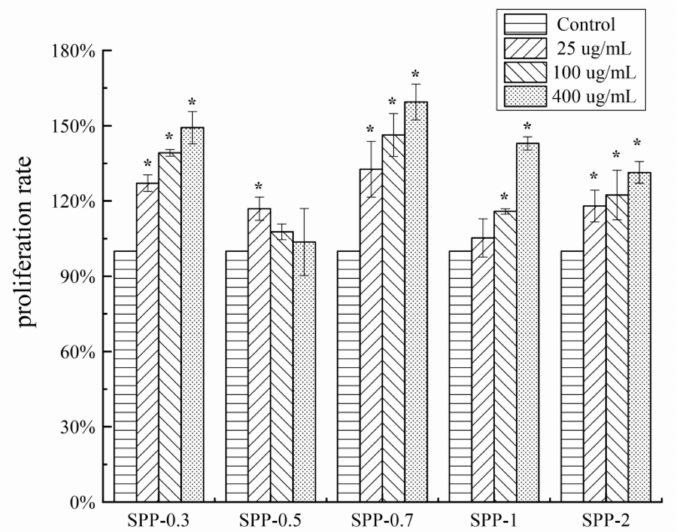
Figure 4. Mouse spleen cell proliferation effects of five polysaccharide fractions with different concentrations (25, 100, and 400 µ g/mL) (mean ± SD). The asterisk (*) on the bars indicated the significance difference ( p < 0.05) in proliferation rate between experimental group and control group according to one-way ANOVA